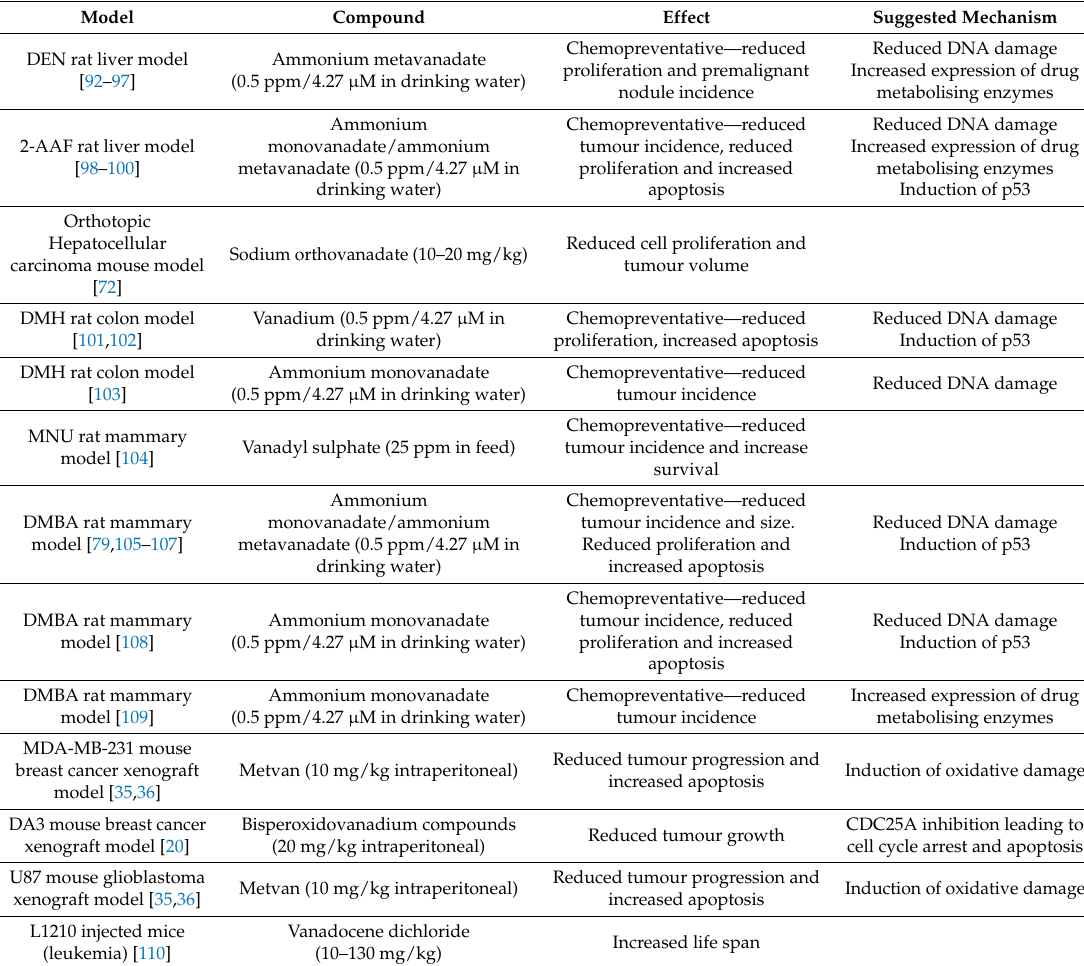
Table 2. Summary of some reported anti-cancer activities of vanadium in animal cancer